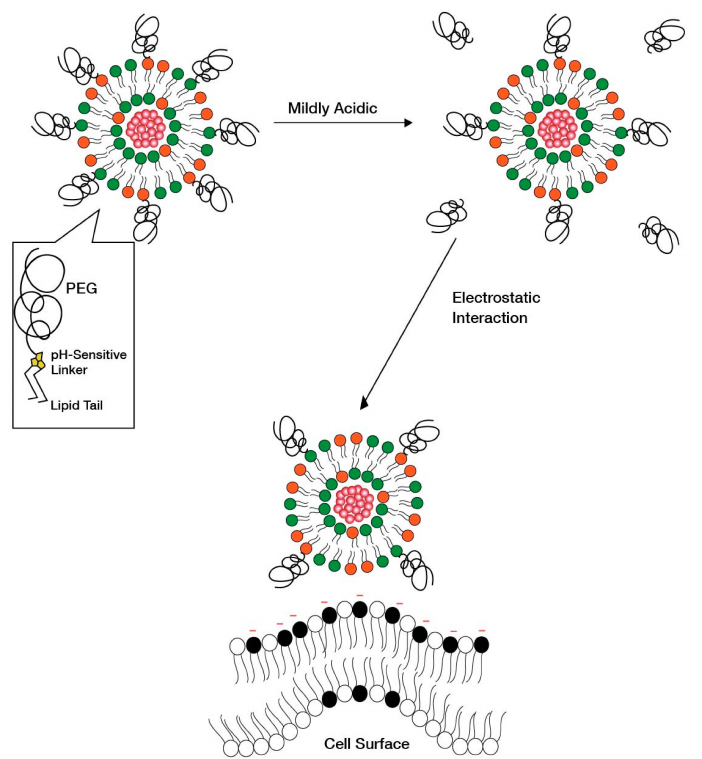
Figure 12. Enhanced interaction of LNPs with the endosomal membrane after dePEGylation via cleavage of pH-sensitive lipids.